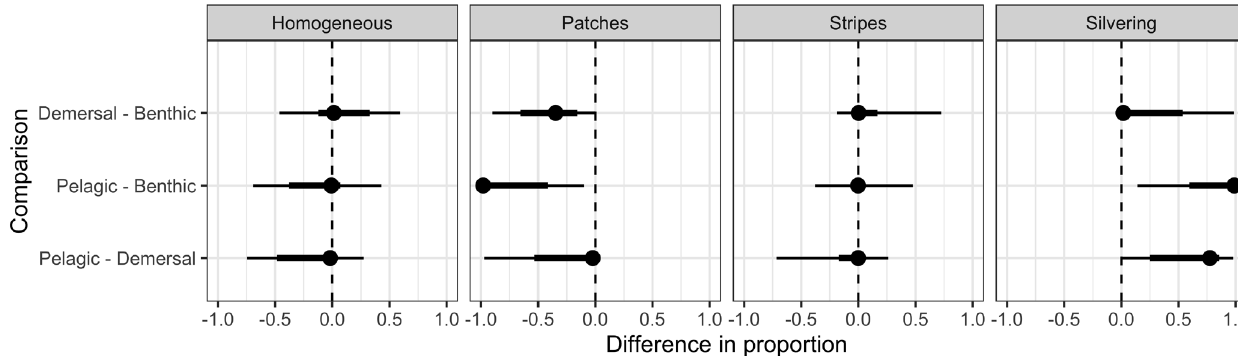
FIGURE 4 | Results of the Bayesian statistical analysis showing the difference in the proportion of coloration types between positions in the water column. Points denote the mode; thick and thin lines denote 67% and 95% credible intervals. Comparisons based on the expected values of the posterior predictive distribution. The analysis indicated that presence of contrasting contour breaks patches is more frequent in benthic than in demersal and pelagic species; and that silvering is more frequent in pelagic species than in demersal and benthic